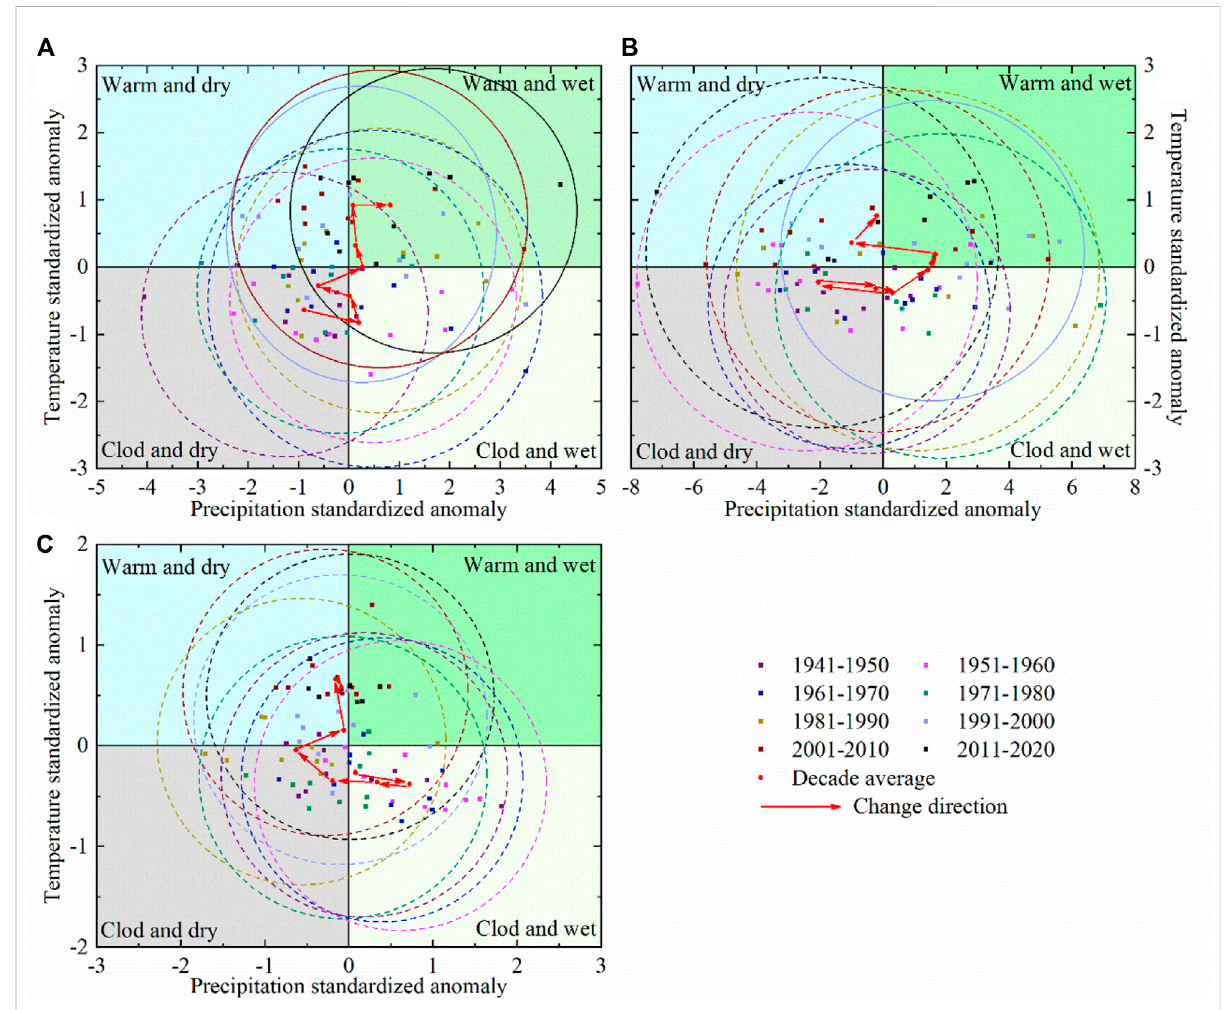
FIGURE 9 Interdecadal distribution of temperature and precipitation anomalies in PCA (A) , NAm (B) , NAf (C) from 1941 to 2020.